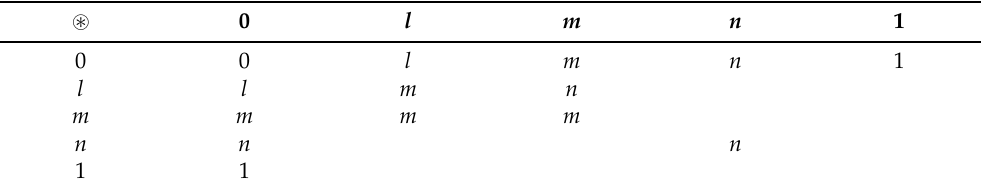
Table 17. The partial operation (cid:126)